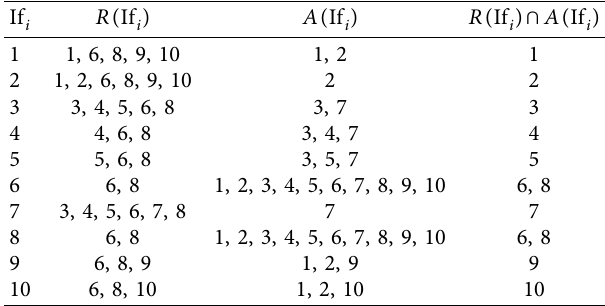
Table 1: Factors influencing the information security of smart cities in the first hierarchy.